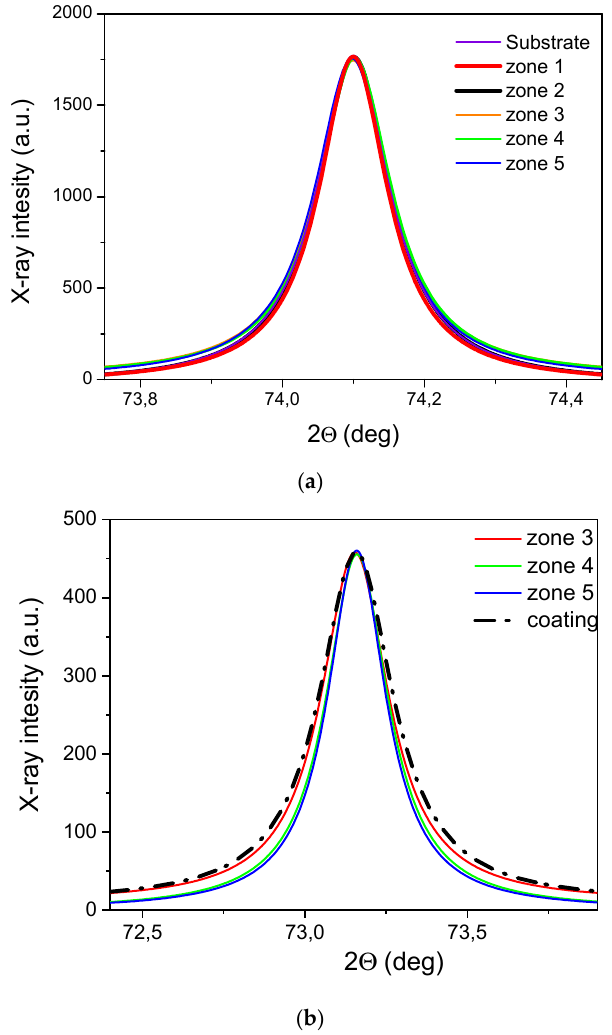
Figure 8. Cu (220) peak ( a ) and W (211) peak ( b ) collected in different positions in the interlayer. To make the comparison of the peak broadening easier, peaks were suitably shifted to occupy the same central position.